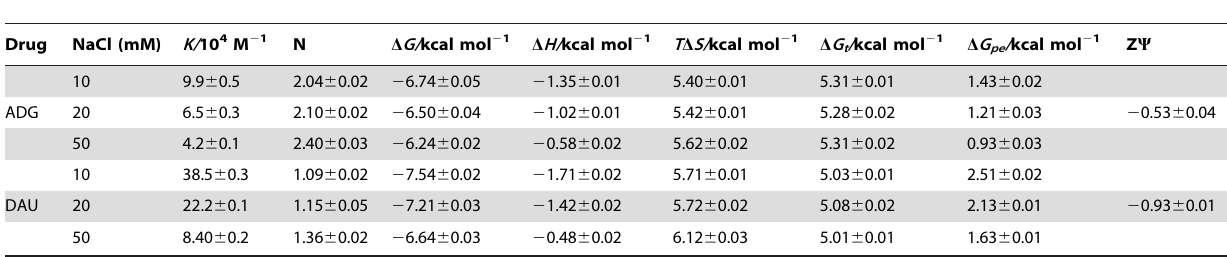
Table 2. ITC derived thermodynamic profiles for the binding of ADG and DAU to tRNA at different Na + concentrations in CP buffer at 20 u